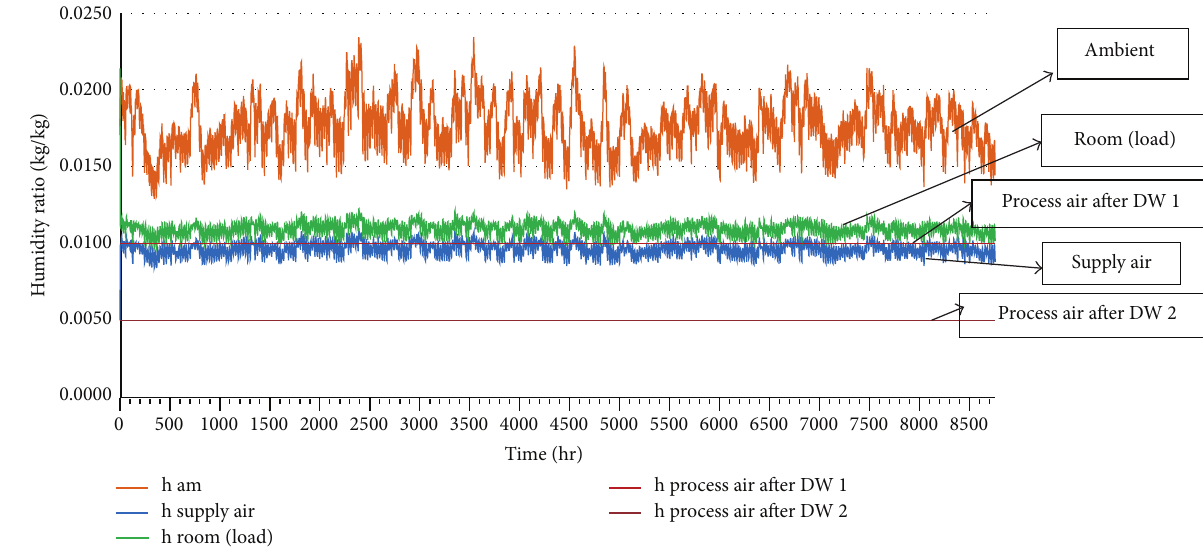
Figure 15: Humidity ratio (kg/kg) of different components versus time (hr) in two-stage recirculation mode.